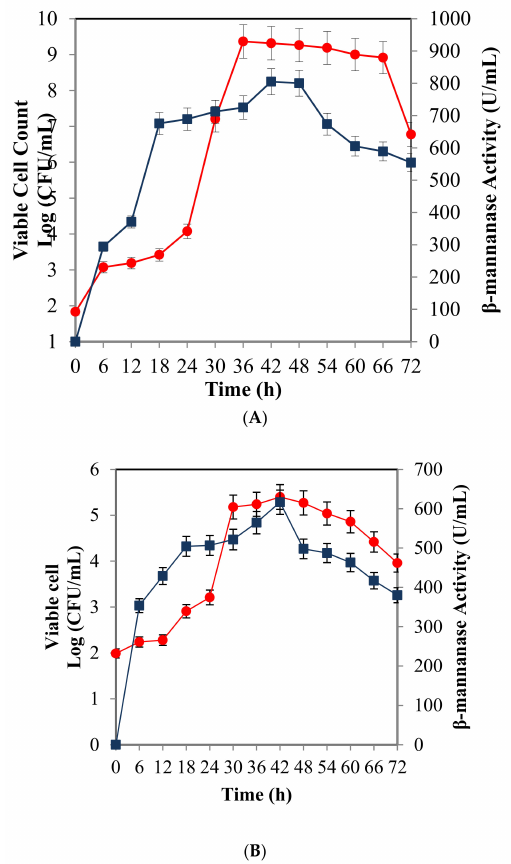
Figure 4. Growth of B. subtilis ATCC 11774 and β -mannanase production in a shake flask ( A ) and 2-L bioreactor( B )usingoptimizedmedium. Symbols: ( • )growthof B.subtilis ATCC11774; ( (cid:4) ) β -mannanase